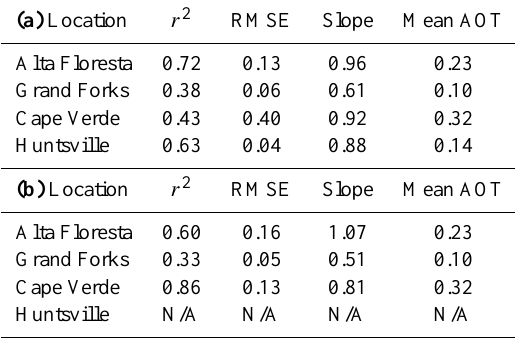
Table 3. Coefficient of determination, root-mean-squared error (RMSE), and best-fit slope of VIIRS estimated nighttime τ com- pared against estimated nighttime Level 2.0 AERONET τ for the new method presented in this study (a) and the method presented in Johnson et al. (2013) (b) . Average AERONET τ for each location is provided for